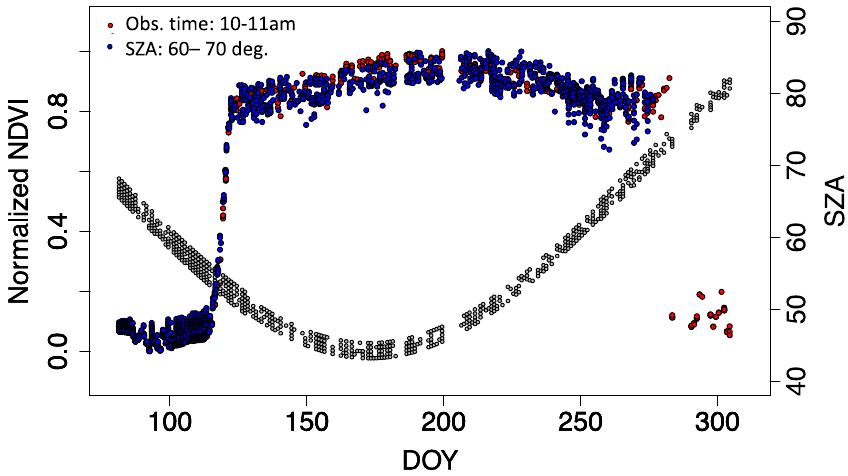
Figure 5. Seasonal course of the normalized NDVI (=(NDVI − NDVI min )/(NDVI max − NDVI min )). Red circles are the measurements near the morning satellite overpass timings (10 to 11 am in AKST). Blue circles are the NDVI measurements when the solar zenith angle was between 60° to 70°. Grey circles are solar zenith angles corresponding to the morning satellite overpass timings (10 to 11 am in AKST).